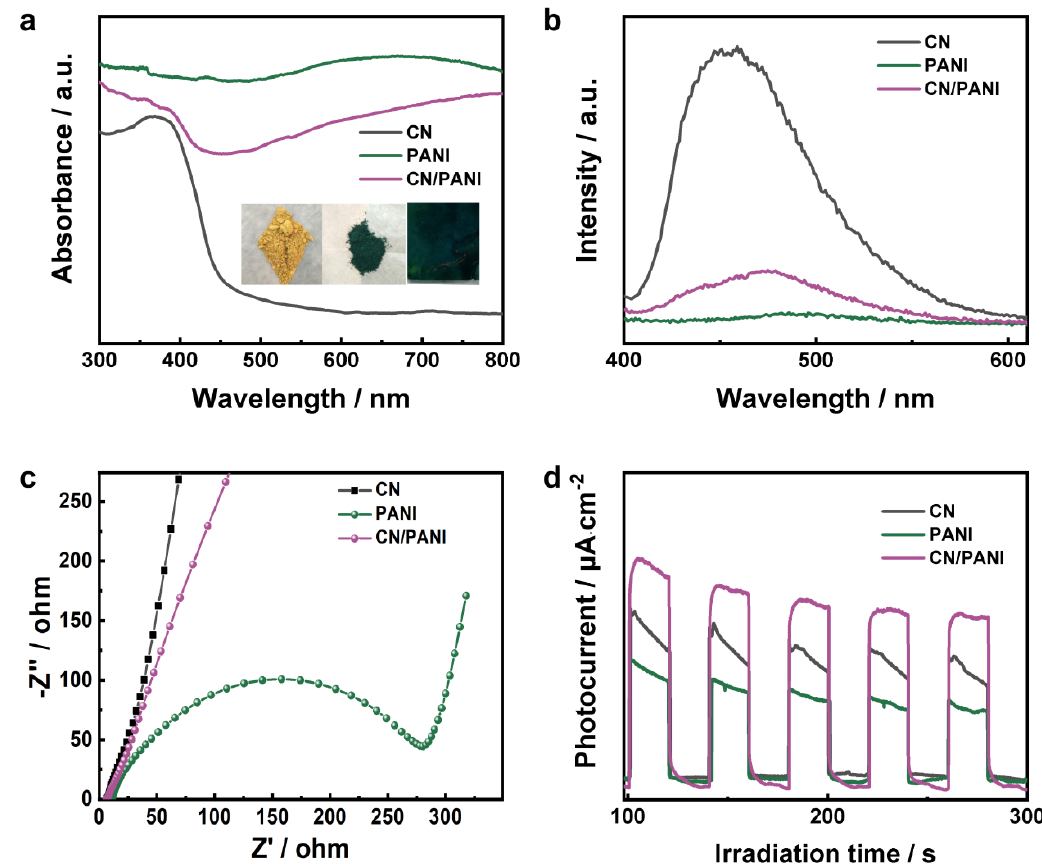
Figure 7. ( a ) UV-Vis diffuse reflectance spectra and optical pictures (inserted ones); ( b ) PL emission spectra; ( c ) EIS spectra; and ( d ) periodic on/off photocurrent response for the pristine CN, PANI, and CN/PANI heterojunction film.